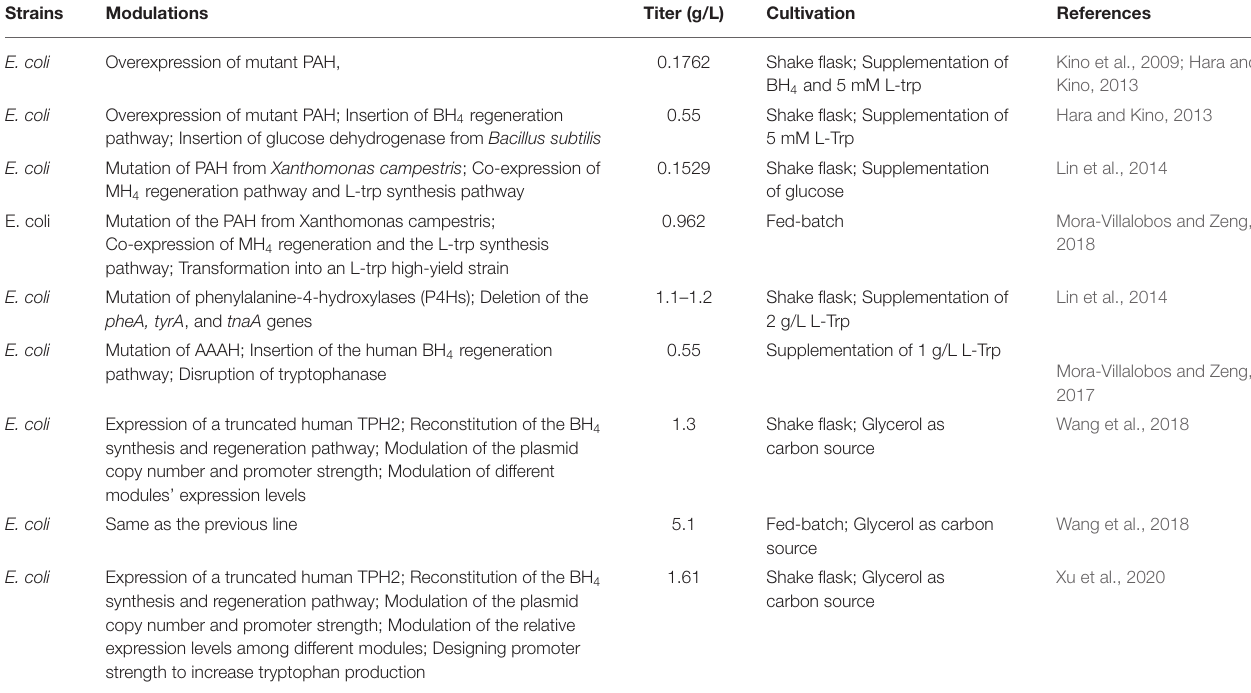
TABLE 1 | Overview of 5-HTP production by